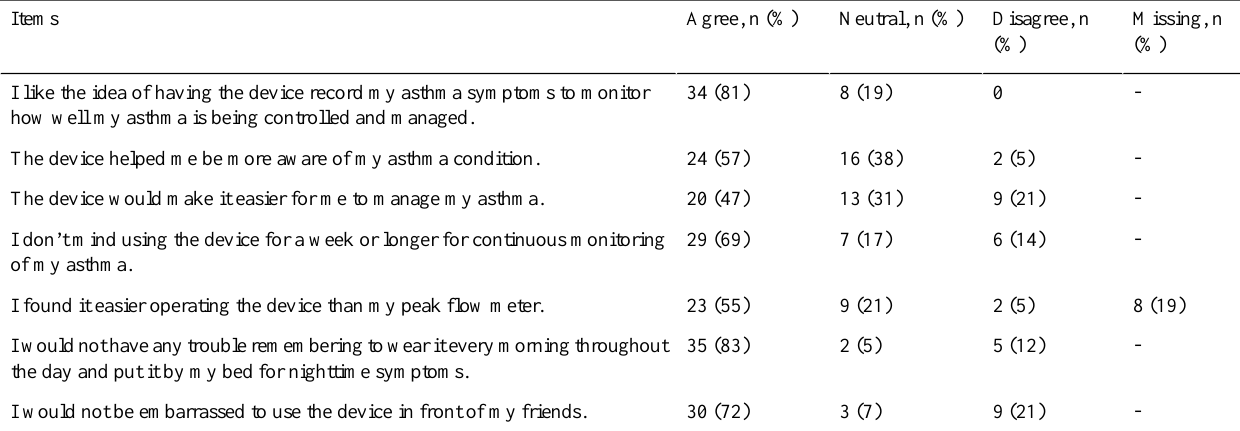
Table 3. Summary of the user acceptance survey for each item